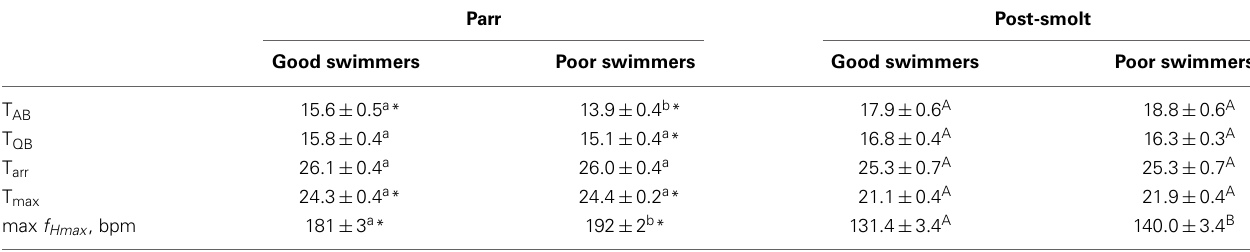
Table 2 | Comparison of rate transition temperatures ( ◦ C) derived from maximum heart rate ( f Hmax ).